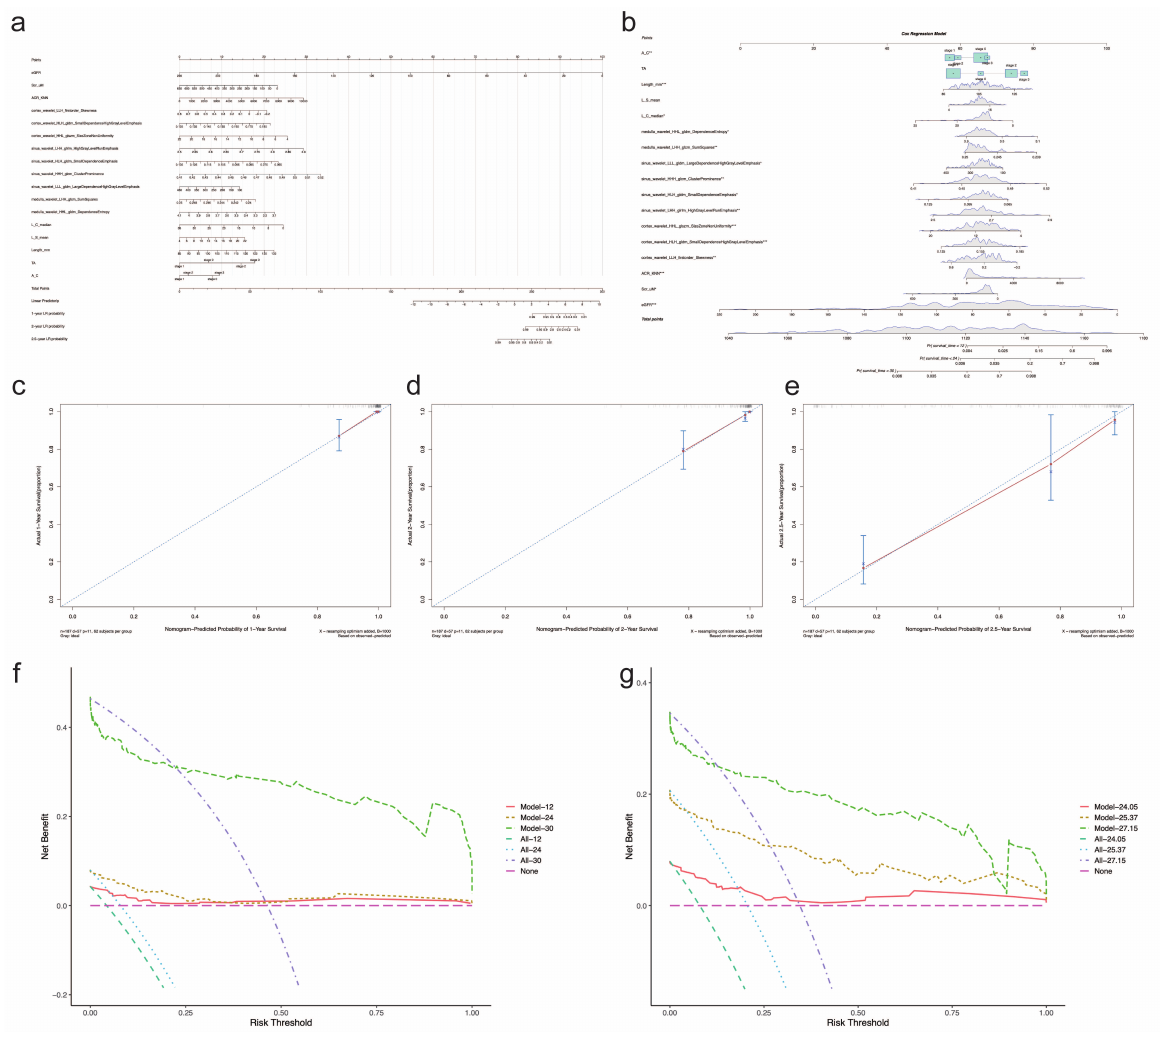
Figure 5. Nomogram for CKD prognosis. ( a ) Prognostic nomogram. ( b ) Dynamic nomogram demonstrating the prediction of overall survival probability by each feature. The risk points (0–100) of each feature can be determined by drawing a vertical line to the line of “Points” on the top from the value of each feature (red dots). A total point was obtained by adding up the risk points of all features. The overall survival probability can be found by drawing a vertical line from the corresponding total point in the line of “Total Points” (the red arrow line). ( c – e ) Calibration curve for predicting survival at 1-year, 2-year, and 2.5-year intervals. The red line represents the performance of the nomogram, which is better if it is closer to the diagonal line, where nomogram-predicted probability equals actual survival proportion. B represents times of Bootstrap validation. ( f , g ) The decision curve for the nomogram. The pink line annotated as “None” represents the assumption that no patients have progressed to CKD stage 3 or over. The dotted line annotated as “All-xx” represents the assumption that all patients have progressed to CKD stage 3 or over. The further the model line from the “None” or “All” lines, the greater net benefit to the model gets. “Model-1” and “All-12” in ( f ) are at the time of 12 months, “Model-2” and “All-24” are at the time of 24 months, and “Model-3” and “All-30” are at the time of 30 months. The values “24.05”, “25.37”, and “27.15” in ( g ) are the quartiles of total follow-up time. “Model” in ( f , g ) all represent the Cox regression model used to build the